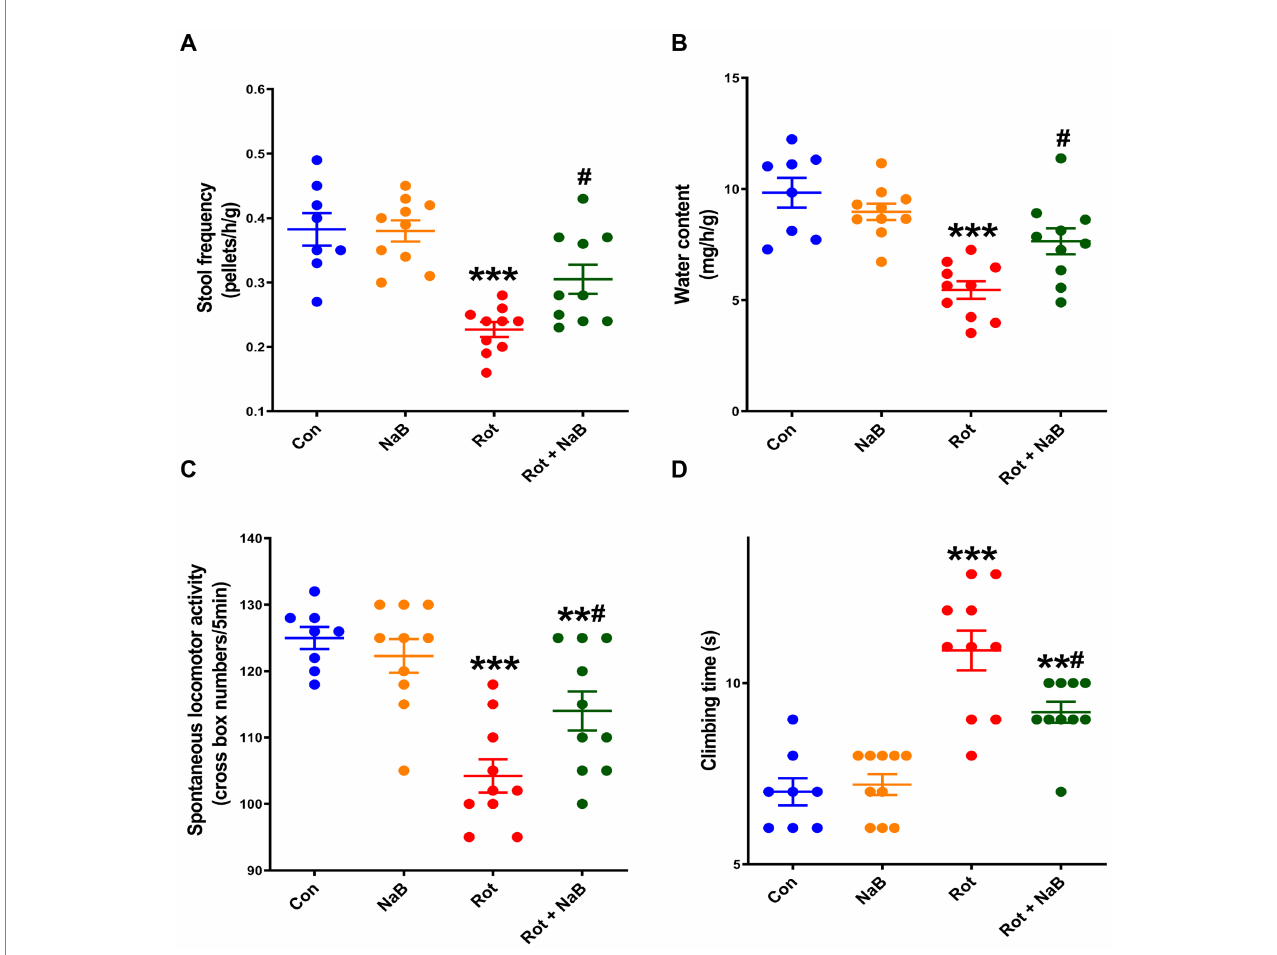
FIGURE 1 NaB alleviates rotenone-induced gut dysfunction and motor deficits. (A) Stool frequency and (B) water content evaluation for gut function. (C) Spontaneous locomotor activity and (D) climbing time measurements for motor function. n = 8–10 per group. The data represent the mean ± SEM. ** p < 0.01, *** p < 0.001 vs. Con group; # p < 0.05 vs. Rot group. Con: control; NaB: sodium butyrate; Rot: